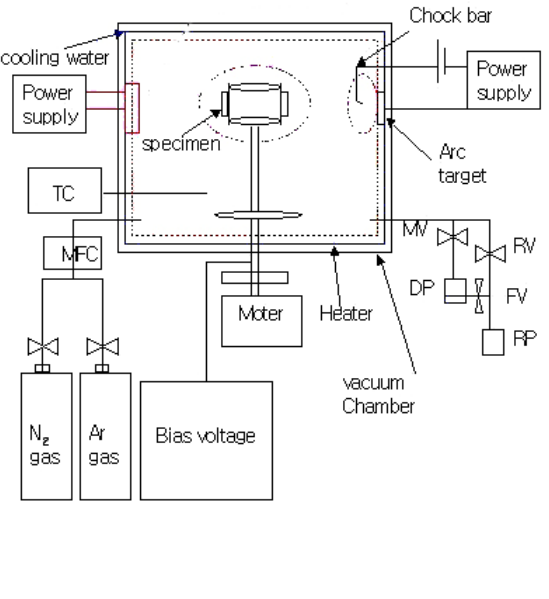
Figure 1. Schematic diagram of the AIP